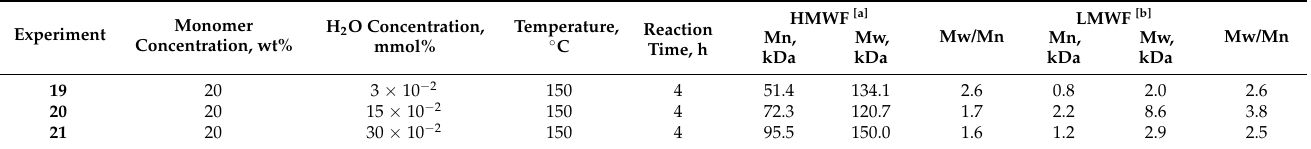
Table 2. Data of experiments on the water effect.